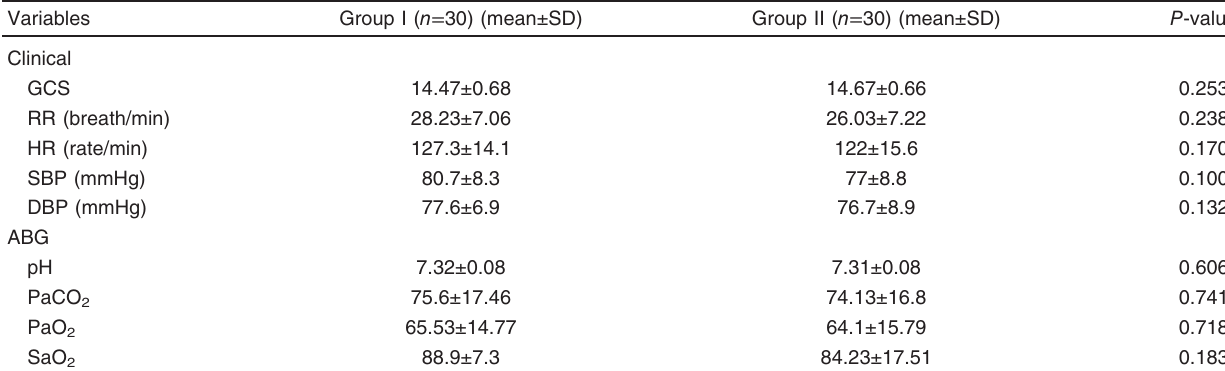
Table 2 Baseline clinical and gasometric parameters of the study groups ( n = 60)